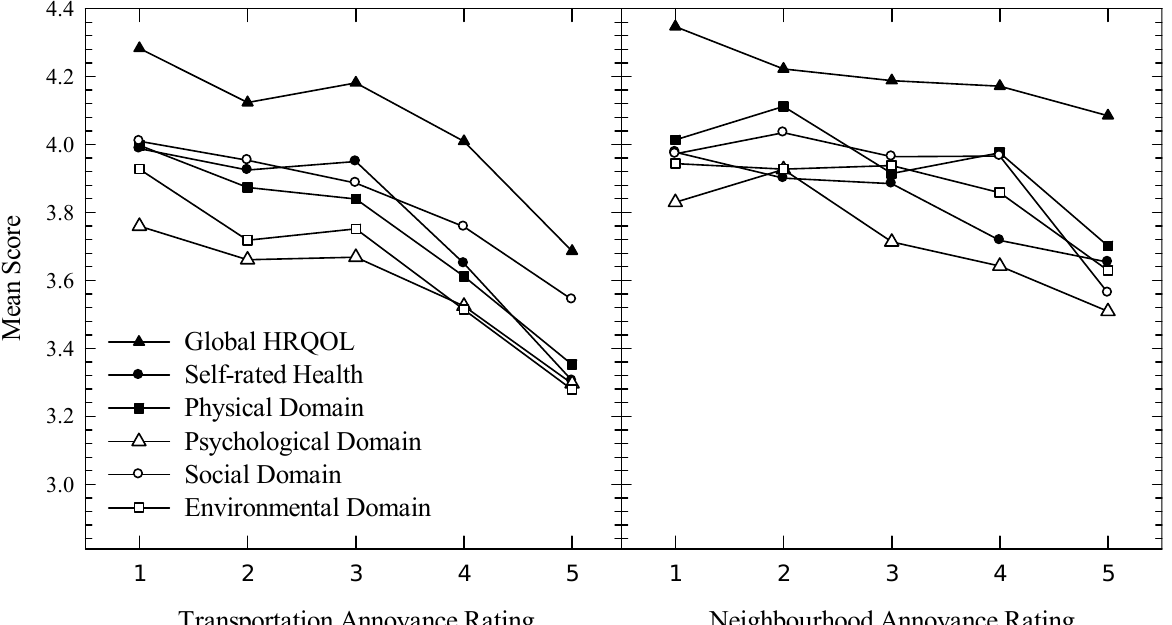
Figure 4. Mean WHOQOL scores plotted as a function of noise annoyance, without regard to area. The left plot is for transportation noise annoyance, the right plot for neighbourhood noise